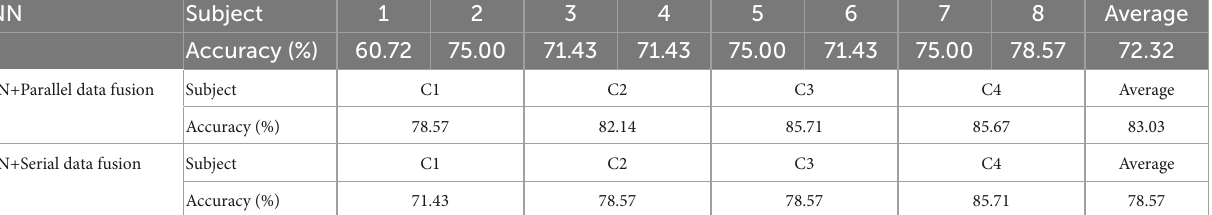
TABLE 3 Results of convolutional neural network (CNN) single-trial P300 classification for centralized multi-person data fusion and single-person mode.